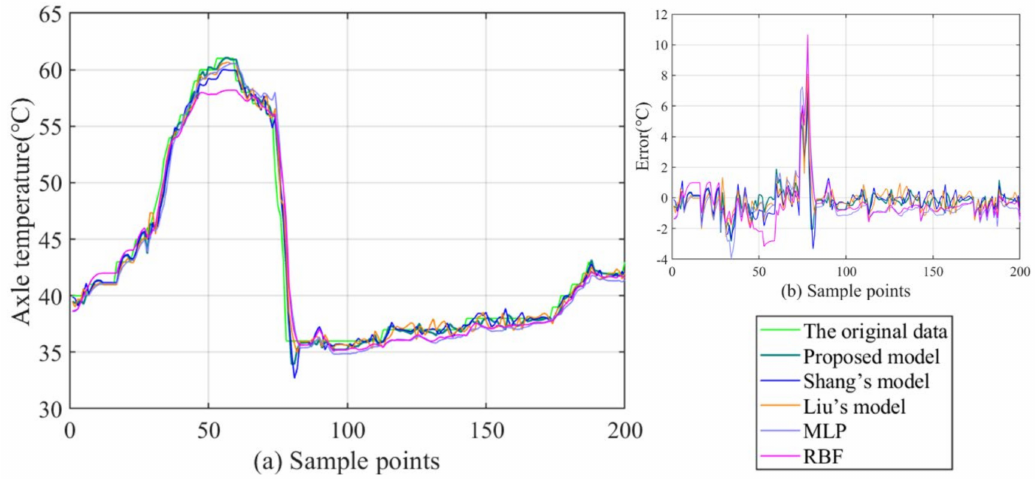
Figure 13. Prediction results and errors of series #1: ( a ) prediction results; ( b ) error distribution.